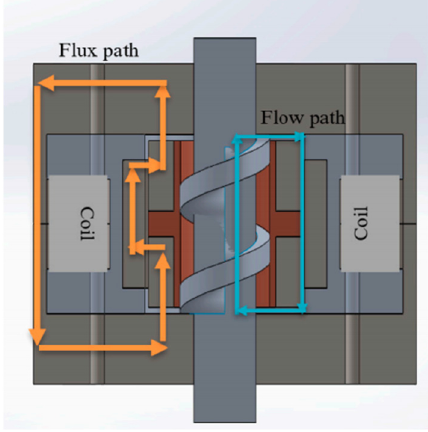
Figure 5. Spiral flow rotating MRD [40,41].